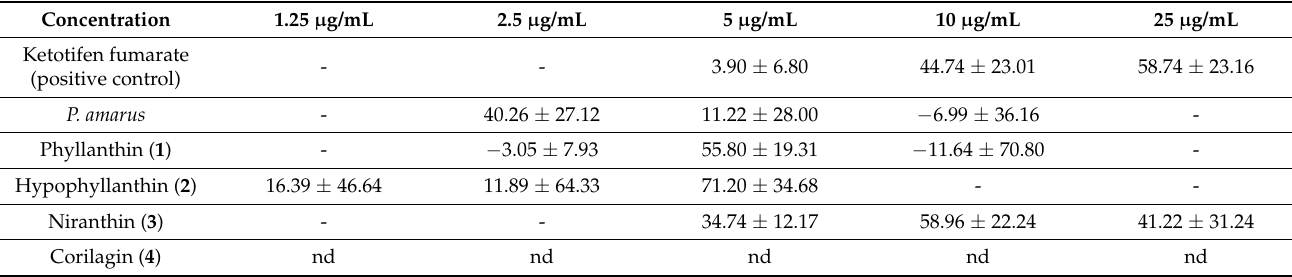
Table 7. Inhibitory activity towards histamine release of P. amarus extract and its compounds. Concentration